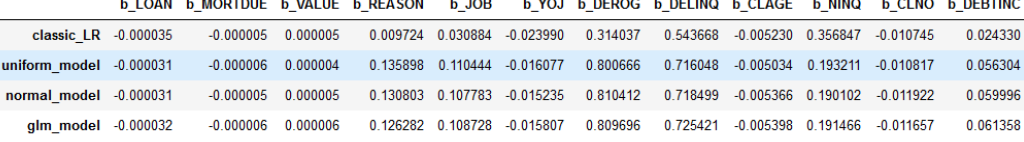
Figure 16. Comparing the coefficients for class logistic regression and three Bayesian models with various standard priors.